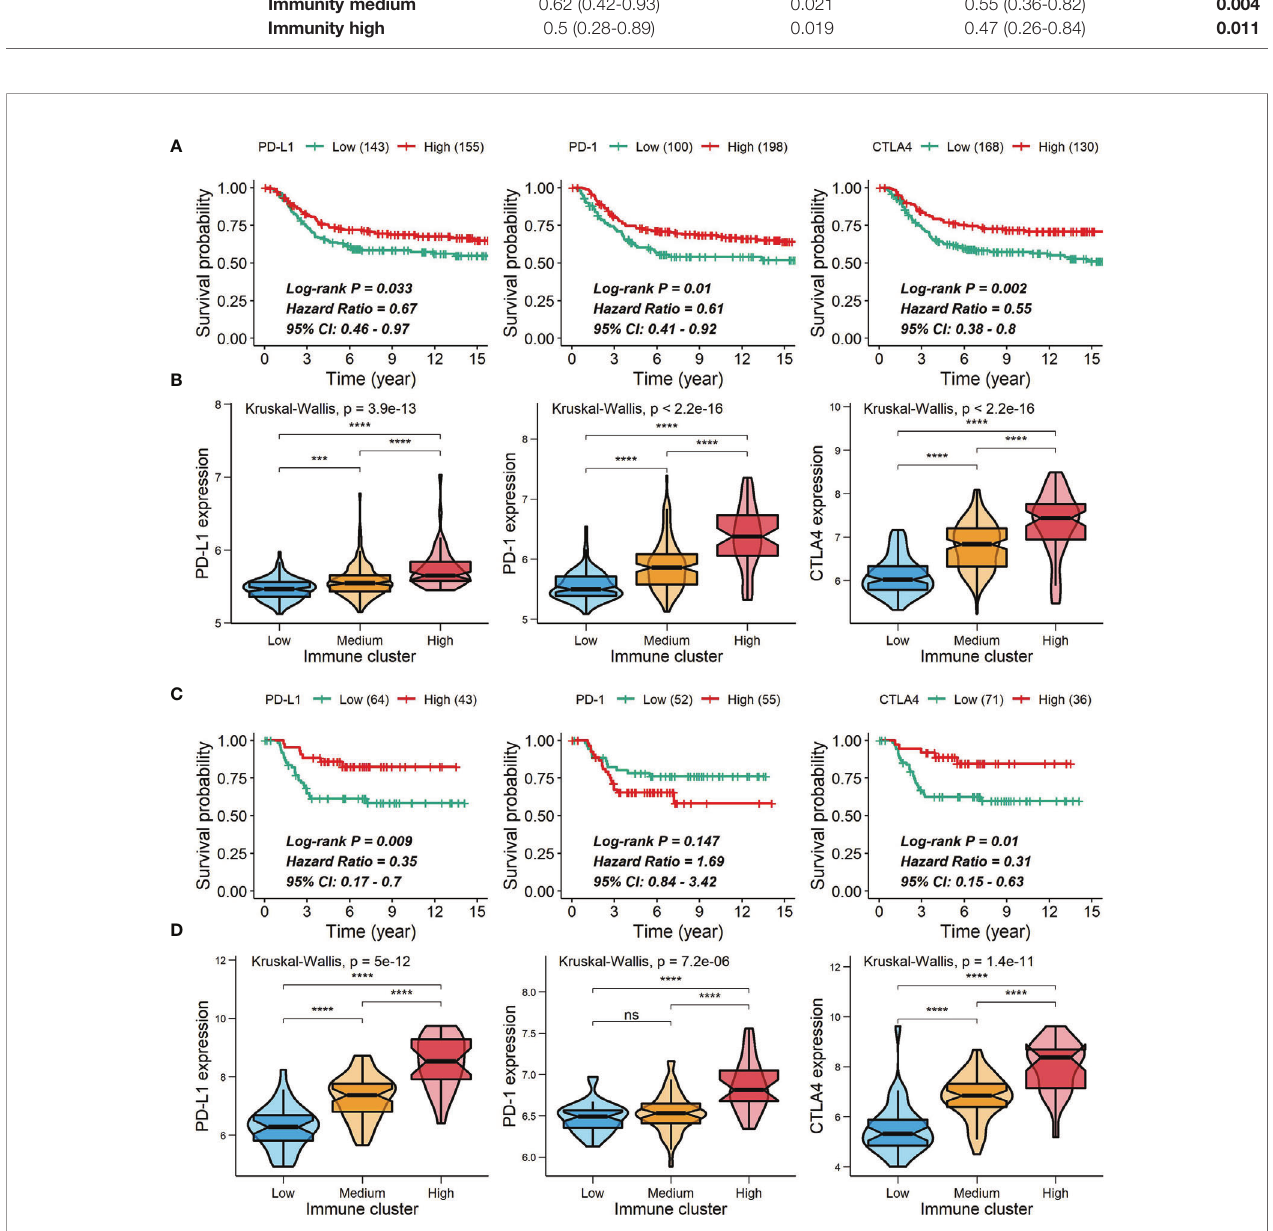
FIGURE 9 | Correlations of PD-L1, PD-1 and CTLA4 expression with survival and comparison of PD-L1, PD-1 and CTLA4 expression among the immune clusters. (A, C) Correlations of PD-L1, PD-1 and CTLA4 expression with survival in the METABRIC cohort (A) or the GSE58812 cohort (C) . (B, D) Differences in PD-L1, PD-1 and CTLA4 expression among the immune clusters in the METABRIC cohort (B) or the GSE58812 cohort (D) ***0.0001 < P < 0.001; **** P < 0.0001; ns, P >